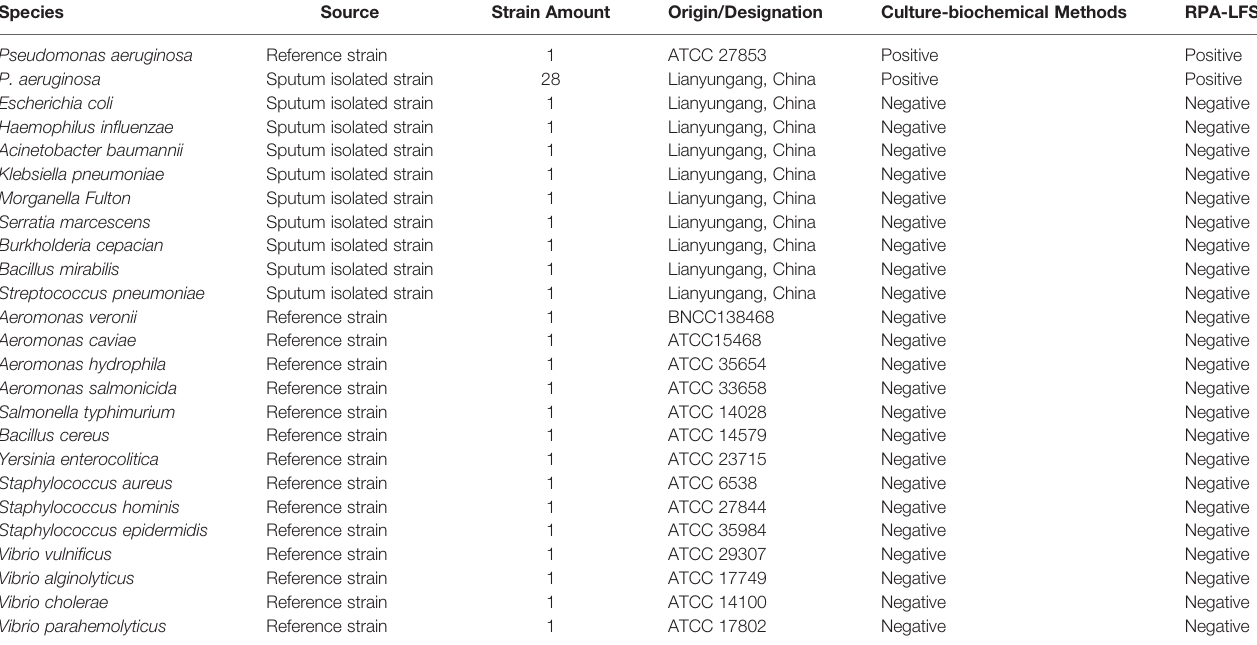
TABLE 1 | Bacterial strains used in the study. Species Pseudomonas